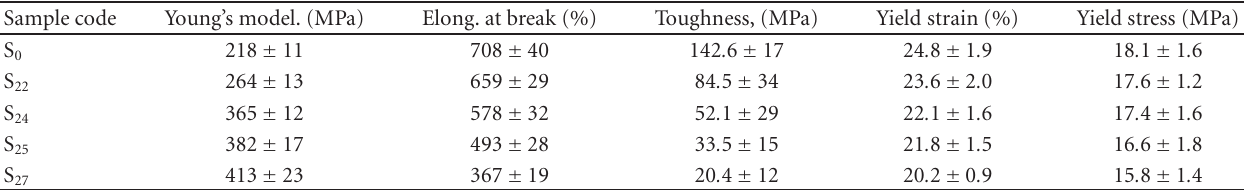
Table 2: Comparative data of mechanical properties ( ± error point) of PAN and PAN/MMT nanocomposites. Sample code